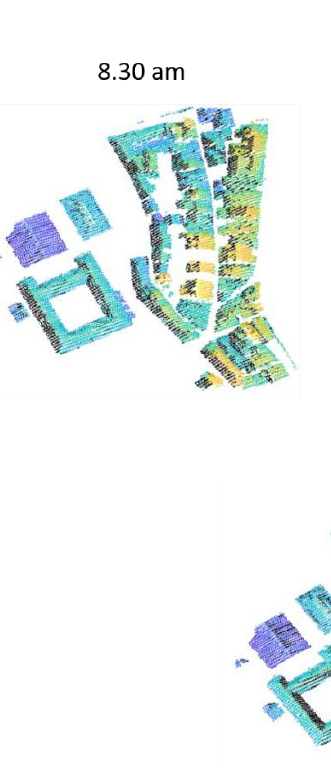
Figure 5. Shading analysis. The shading of the roof at three different times of the day (morning, noon, and afternoon) is represented in black color.